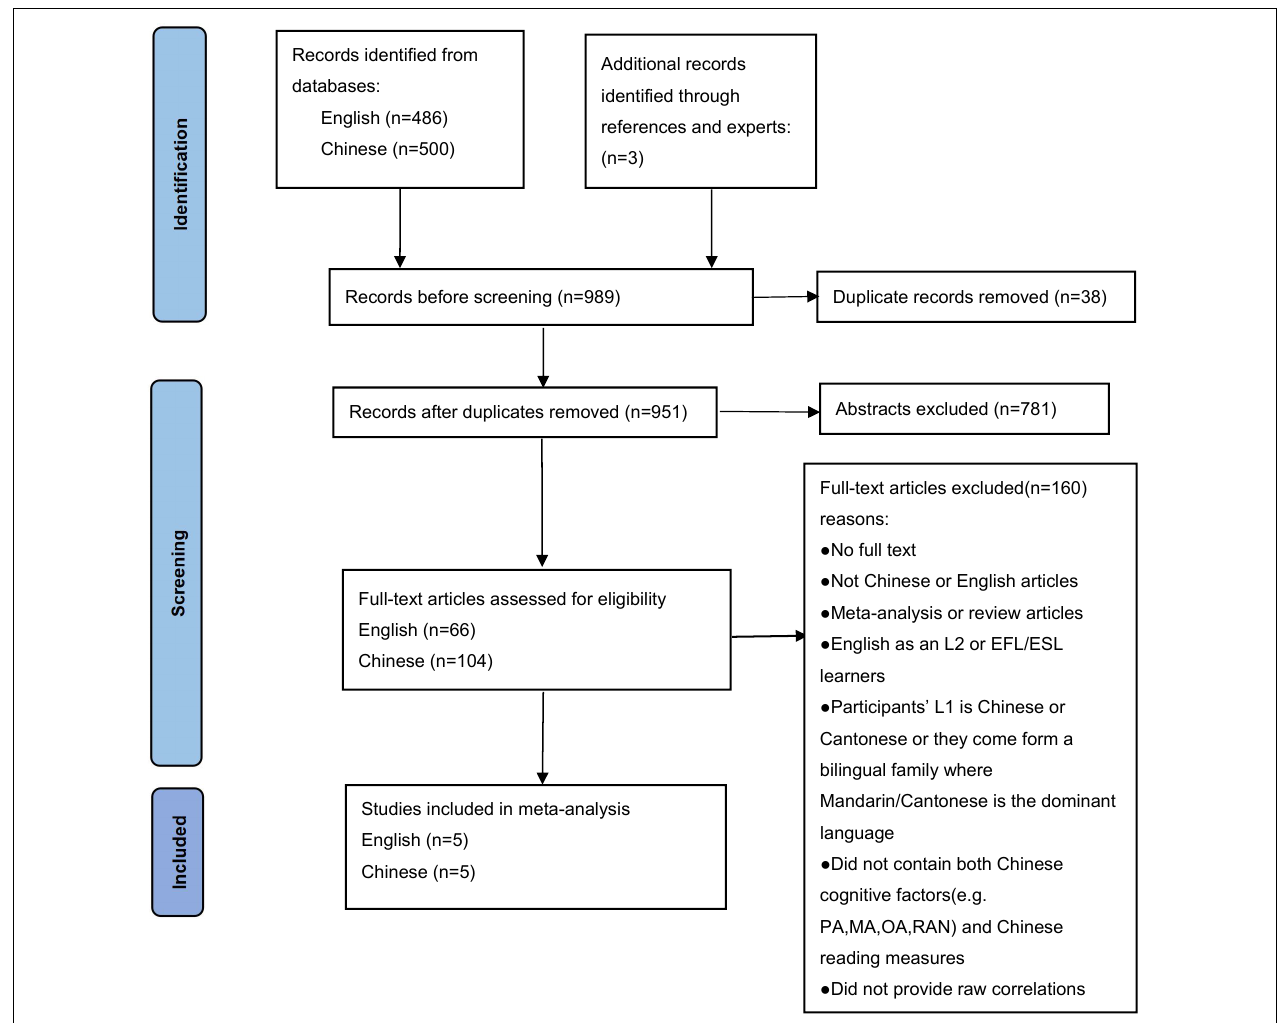
FIGURE 1 | Flow diagram for the search and inclusion of studies (adapted from http://www.prisma-statement.org/).